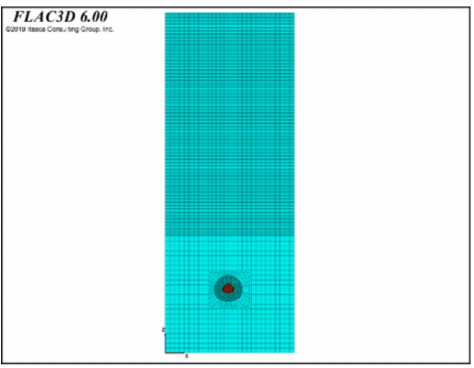
Figure 2. Numerical simulation model of the tunnel built by FLAC3D and grid division. The numerical simulation was performed on the buried depth section. The section needs further grouting under different grades of surrounding rock. A 1 m thick grouting ring was adopted to form a circular cover around the crown. The three grouting methods included 1/4 ring grouting, 1/2 ring grouting, and full grouting (Figure 3). They all followed the axisymmetric distribution on the crown.